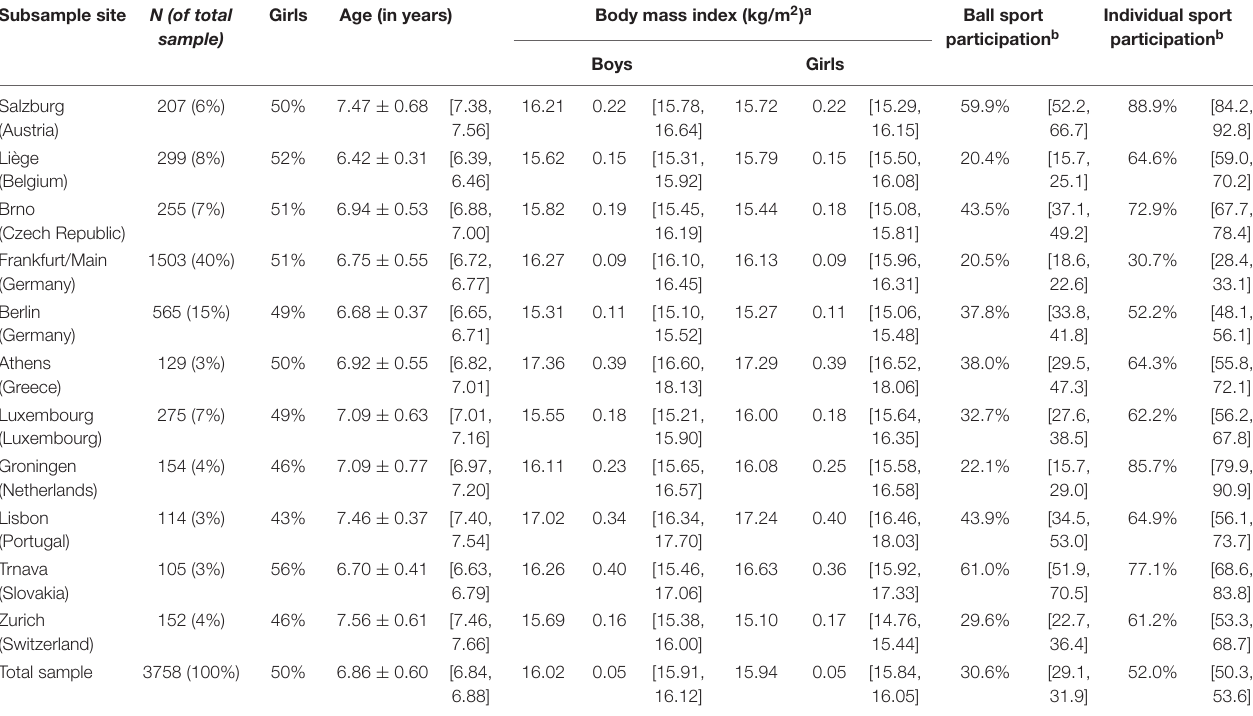
TABLE 1 | Descriptive statistics of age (mean ± SD , 95% CI ) and BMI (mean, SE , 95% CI ) and participation rates (% participating, 95% CI ) in extracurricular physical activity, stratified by subsample site. Subsample site N (of total